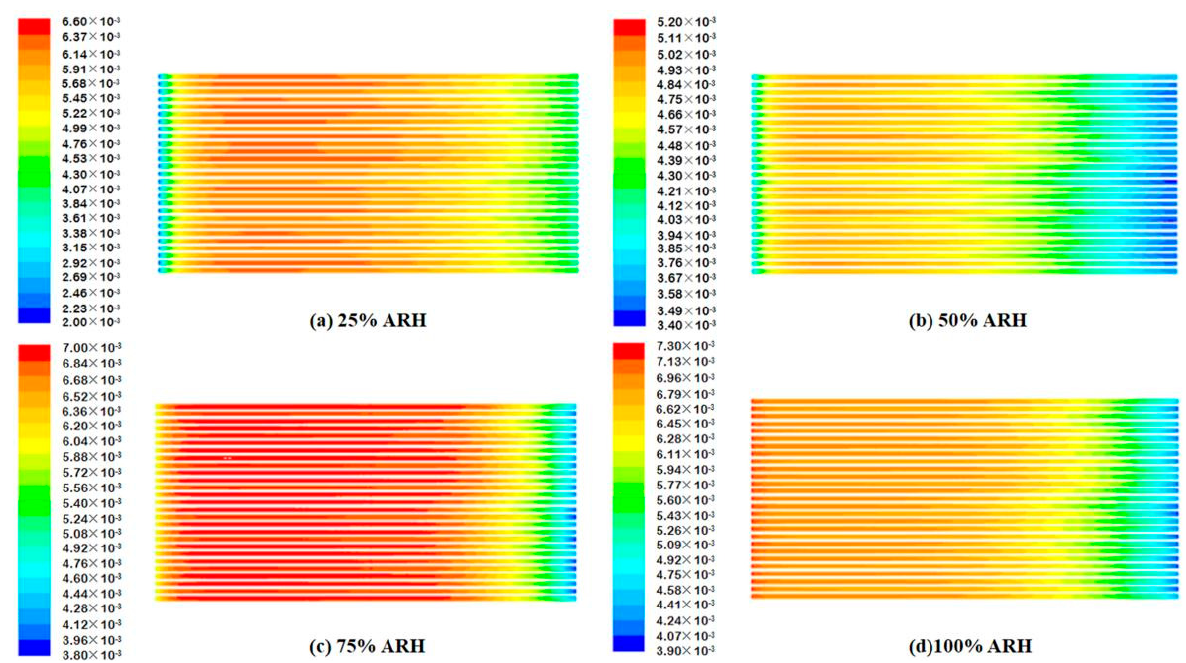
Figure 6. Contours of water molar concentrations (kmol · m − 3 ).